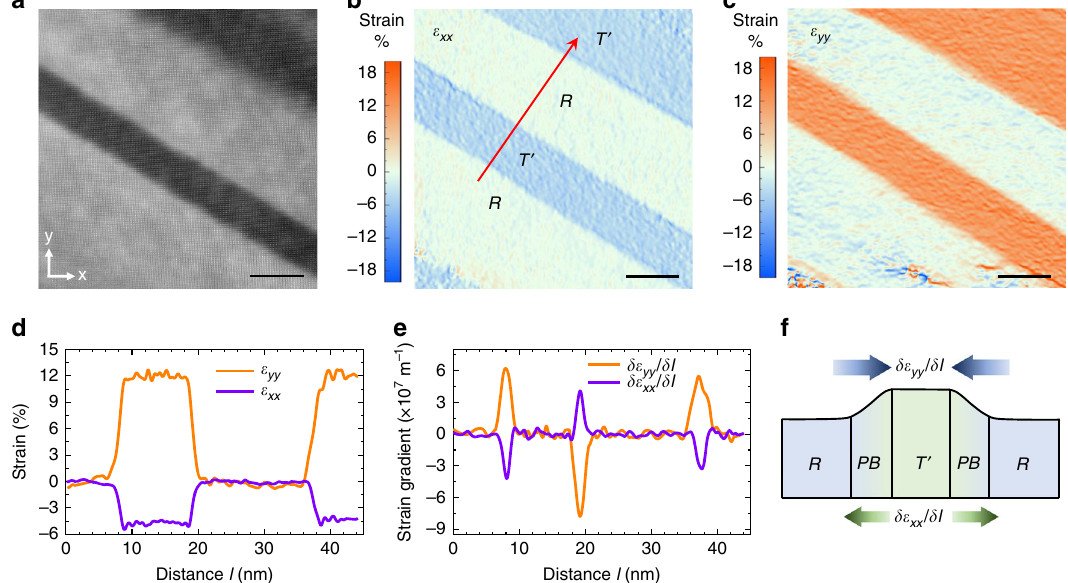
Fig. 3 Strain and strain gradient characterization. a High-resolution STEM cross section image of strained BiFeO 3 /LaAlO 3 thin fi lm for the GPA analysis. Scale bar 10 nm. b In-plane strain ( ε xx ) and c out-of-plane strain ( ε yy ) fi eld. Here, x and y directions are parallel to the LaAlO 3 [100] pc and [001] pc directions, respectively. d Strain and e strain gradient distribution along the direction perpendicular to the phase boundaries marked by red arrow in ( b ). f Schematic showing the strain gradients at the morphotropic phase boundaries. PB: phase boundary, STEM: scanning transmission electron